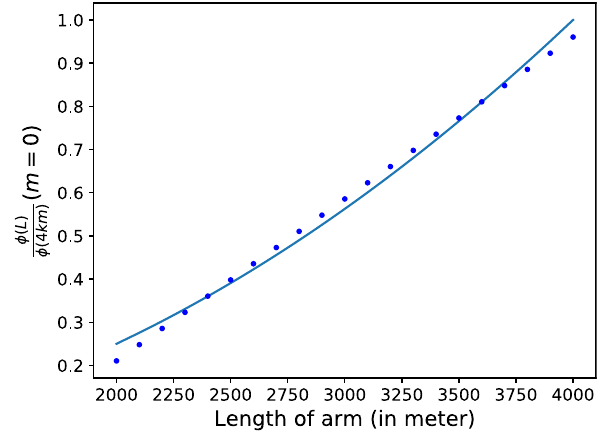
Fig. 3 The variation of δφ( L ) δφ( been shown for m = 0 , p =